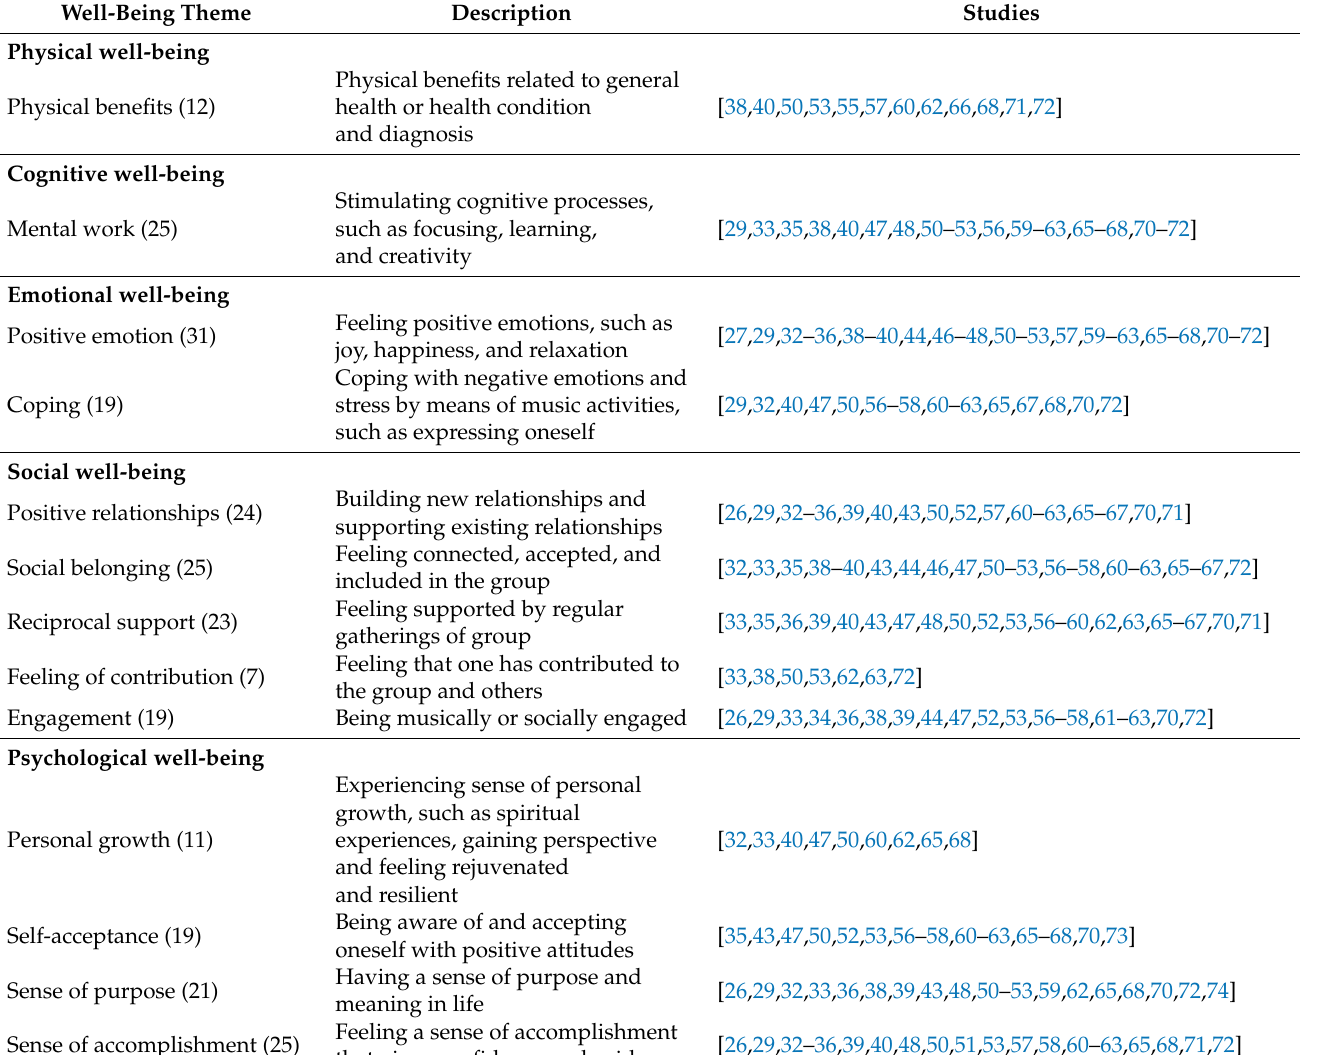
Table 2. Summary of qualitative